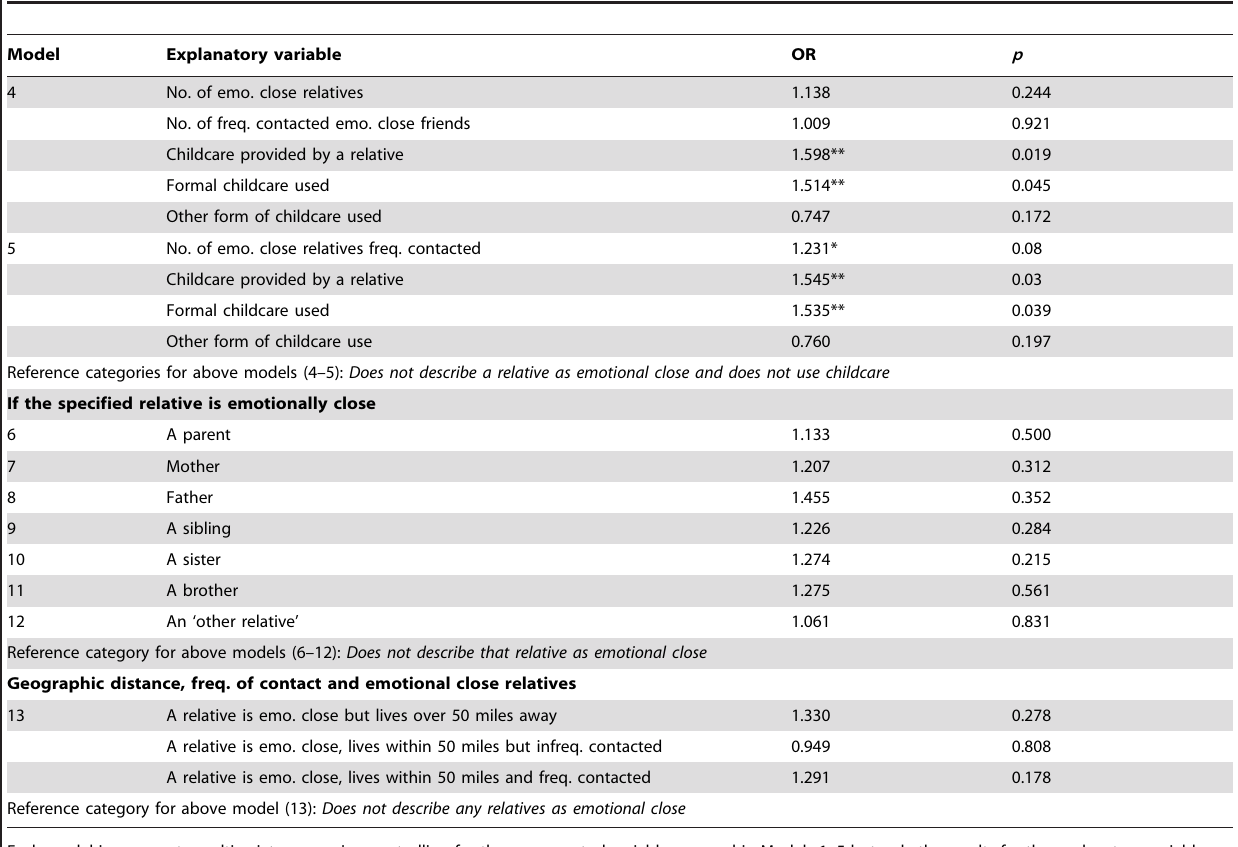
Table 5. Multivariate results – explanatory variables in a combined model and other explanatory variables.